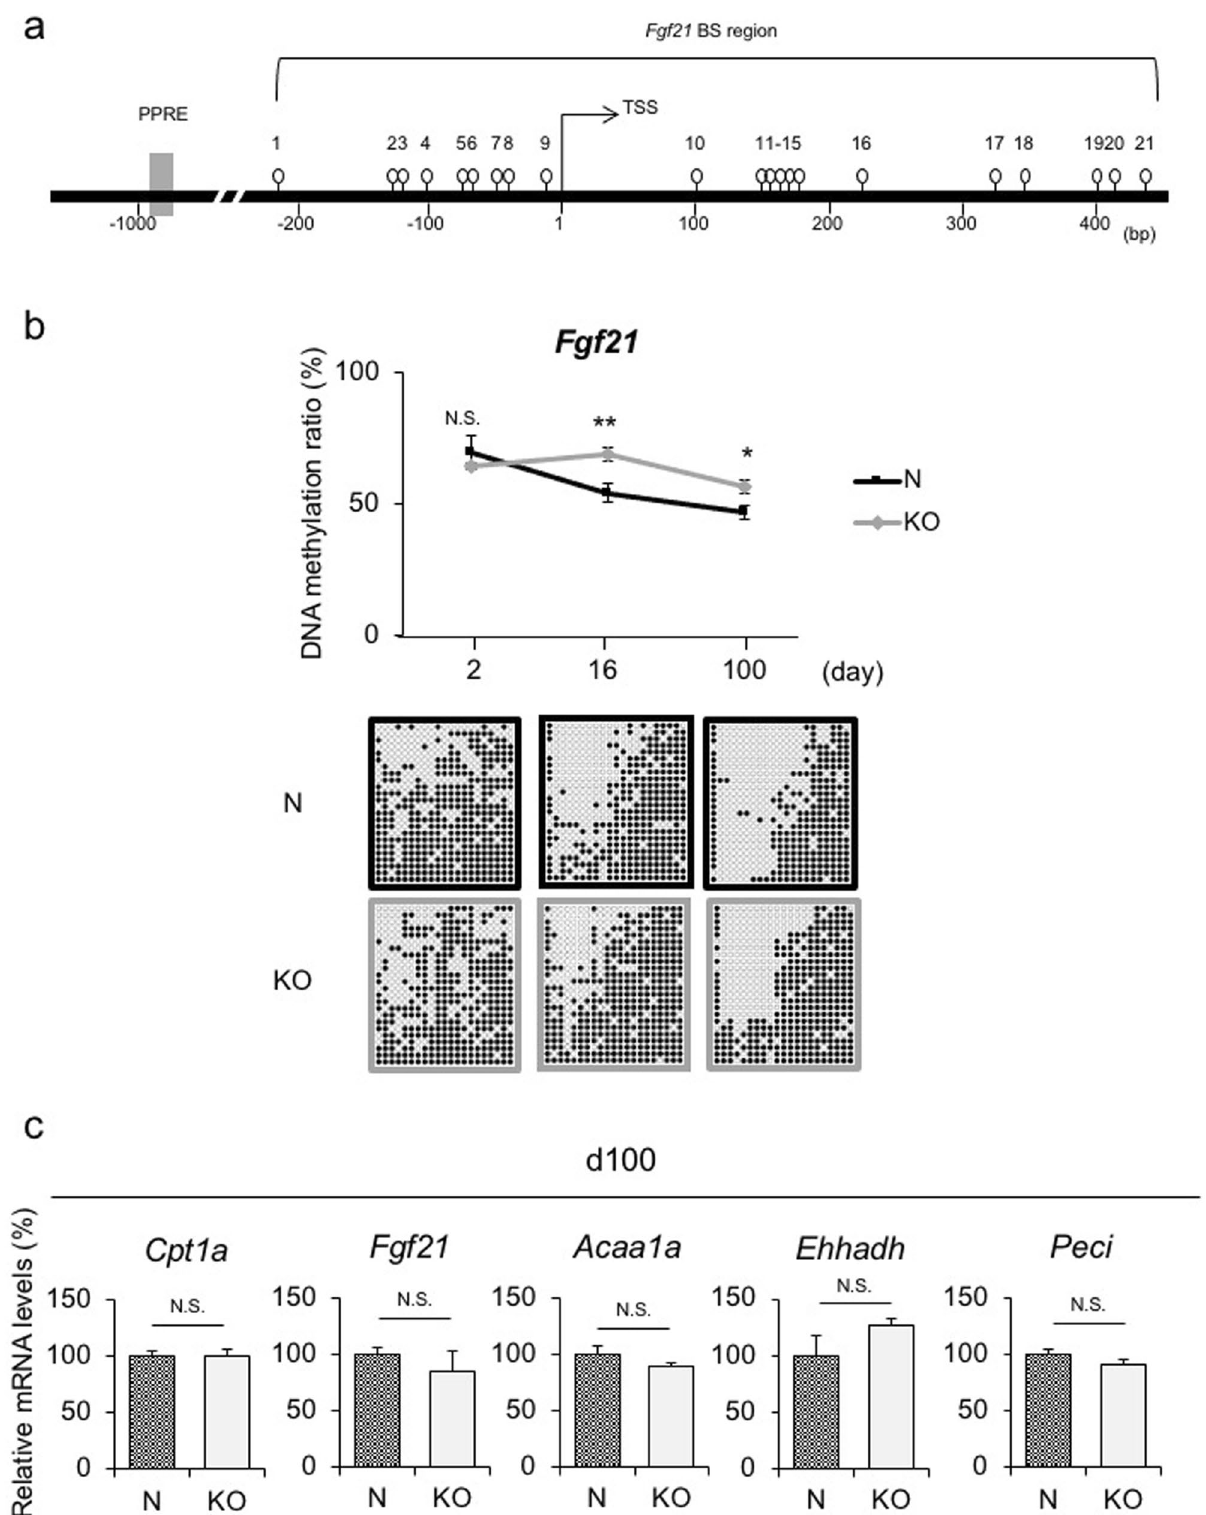
Figure 1. DNA methylation status and gene expression levels of PPARα target genes in livers of KO and N offspring. (a) Schematic representation of the promoter region of Fgf21 . Open circles and gray boxes indicate CpG sites and PPAR response elements (PPREs), respectively. The bisulfite-sequencing (BS) analysis region encompassing the transcription start site (TSS) is indicated. ( b ) Fgf21 DNA methylation status in the livers of N and KO offspring via the BS analysis (n = 4 per group, statistical analysis using a one-way ANOVA with Tukey’s multiple comparison test). Representative BS data are depicted below the graph. Data are expressed as the mean ± SEM. * p < 0.05; ** p < 0.01; N.S., not significant vs. KO offspring. ( c ) Hepatic Cpt1a , Fgf21 , Acaa1a , Ehhadh , and Peci mRNA expression levels on d16, which were DNA hypermethylated on both d16 and d100. (n = 6 per group). Statistical analysis using an unpaired Student’s t -test unless otherwise indicated. Data are expressed as the mean ± SEM. N.S., not significant vs. KO